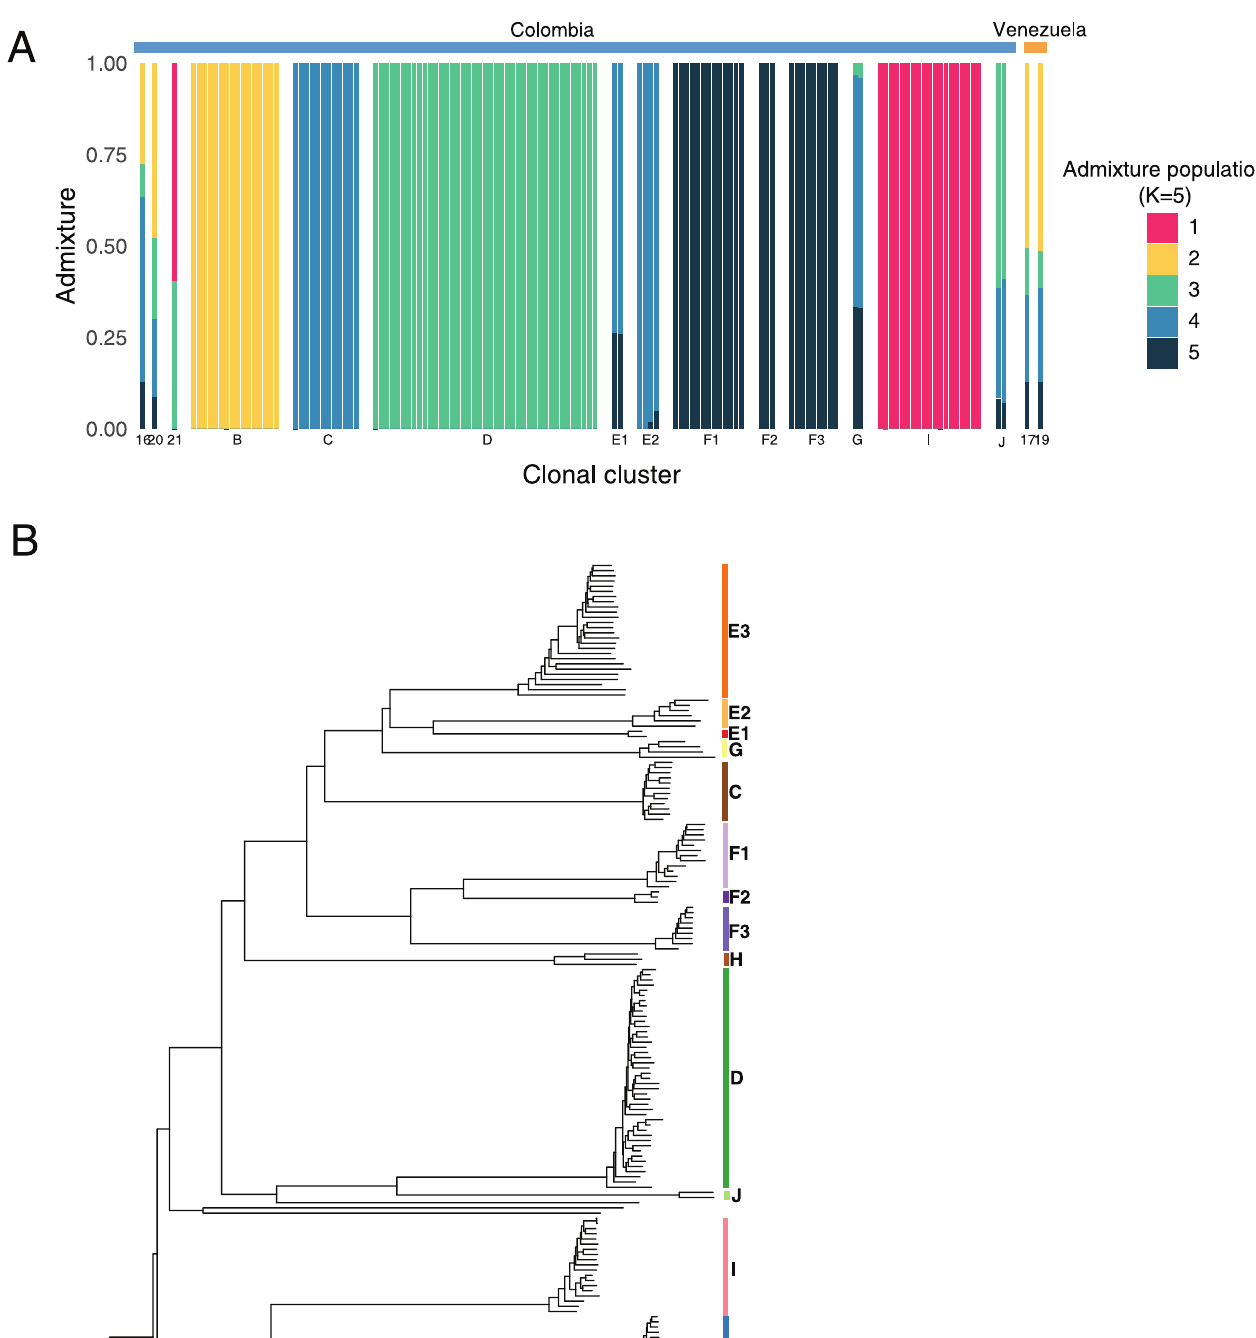
PLOS Pathogens| https://doi.org/10.1371/journal.ppat.1010993 December 21,